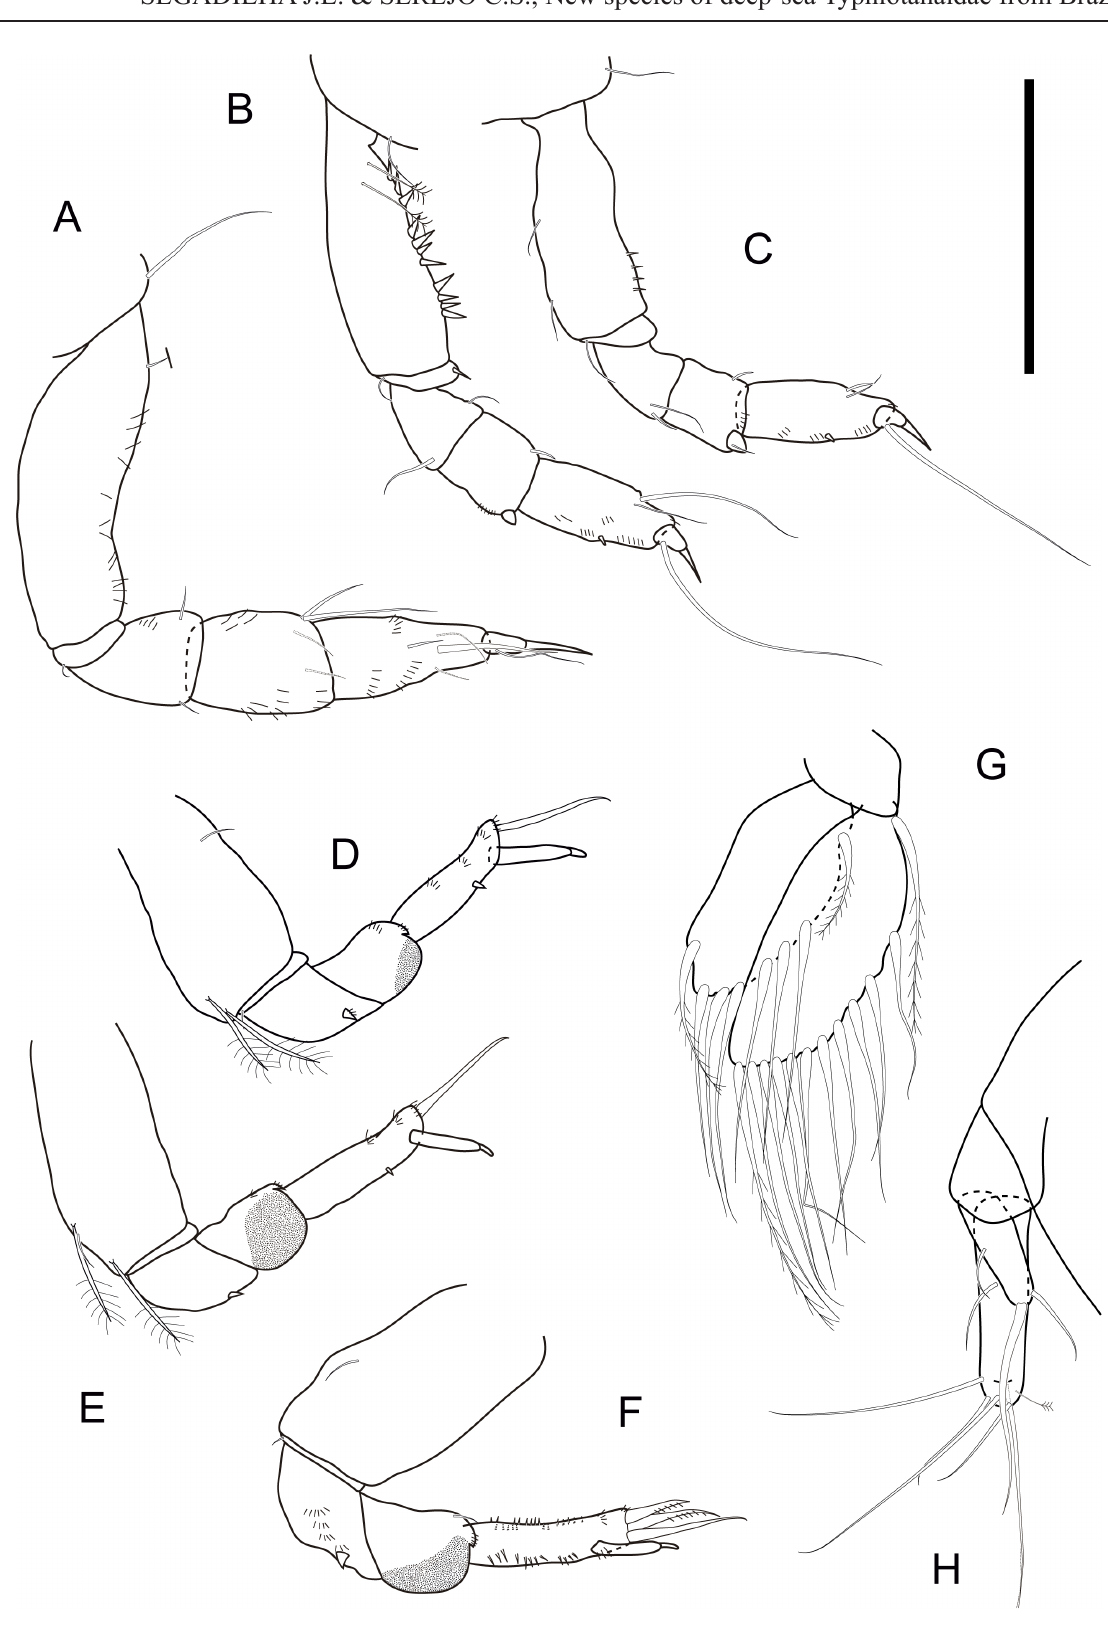
Fig. 10. Typhlotanais bolarticulus sp. nov., paratype (MZUSP 32878), ♀, dissected. A–F . Pereopods 1–6. G . Pleopod. H . Uropod. Scale bar = 0.1